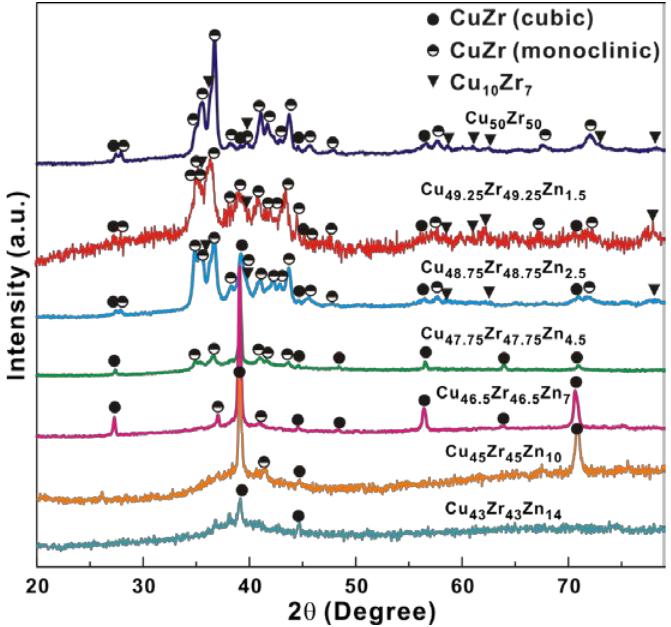
Figure 1. XRD patterns of the as-cast (Cu 0.5 Zr 0.5 ) 100− x Zn x ( x = 0, 1.5, 2.5, 4.5, 7, 10, and 14 at. %) rods with a diameter of 2